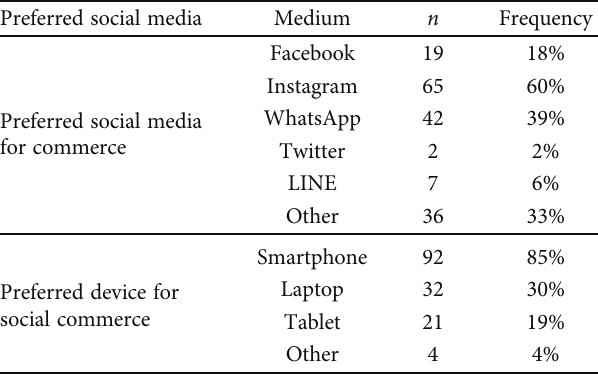
Table 8, the values were less than the threshold of 0.90 [55], thus suitable.